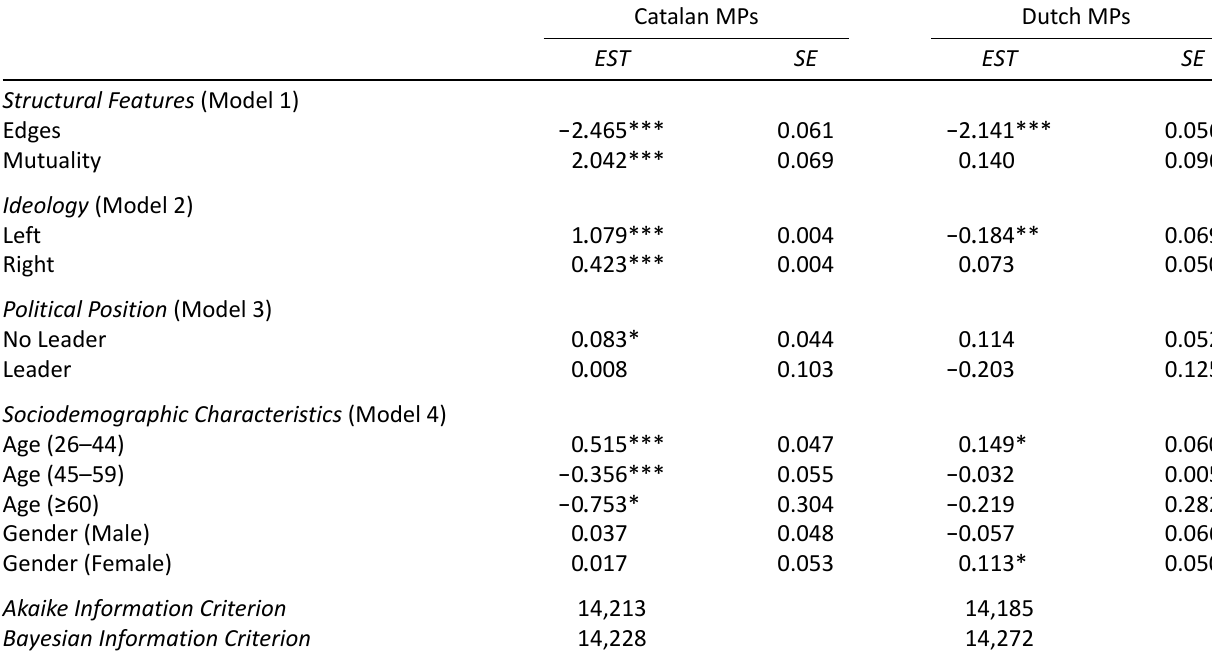
Table 2. Factors underlying communication flows in the Catalan and Dutch MPs’ Twitter mentions networks: Models 1–4.